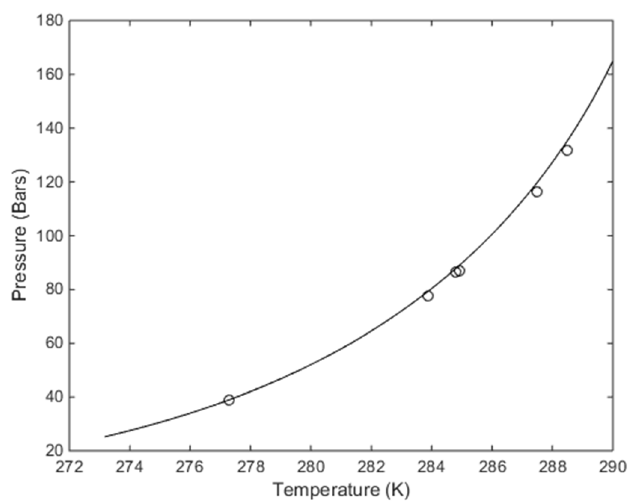
Figure 3. Calculated pressure temperature hydrate stability limits (solid) and experimental data from Tumba et al. [14] (o).